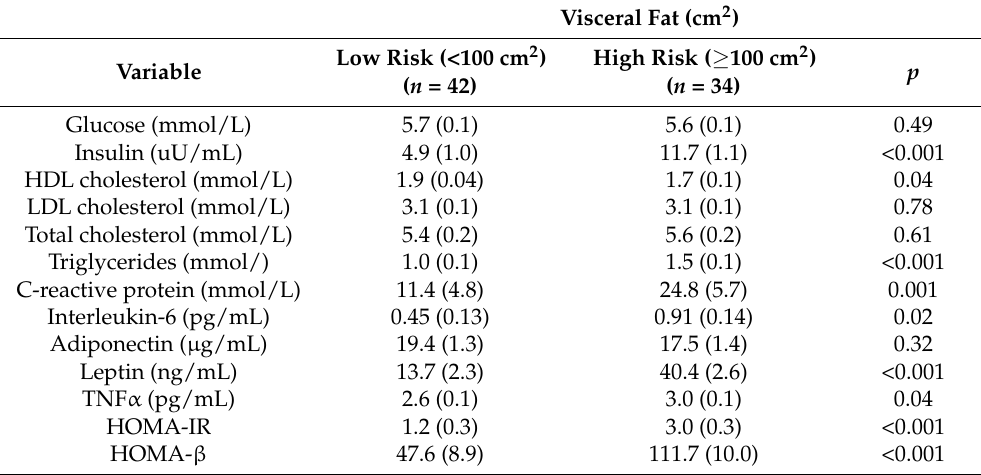
Table 2. Adjusted mean characteristics by established high-risk cut point for visceral fat area.